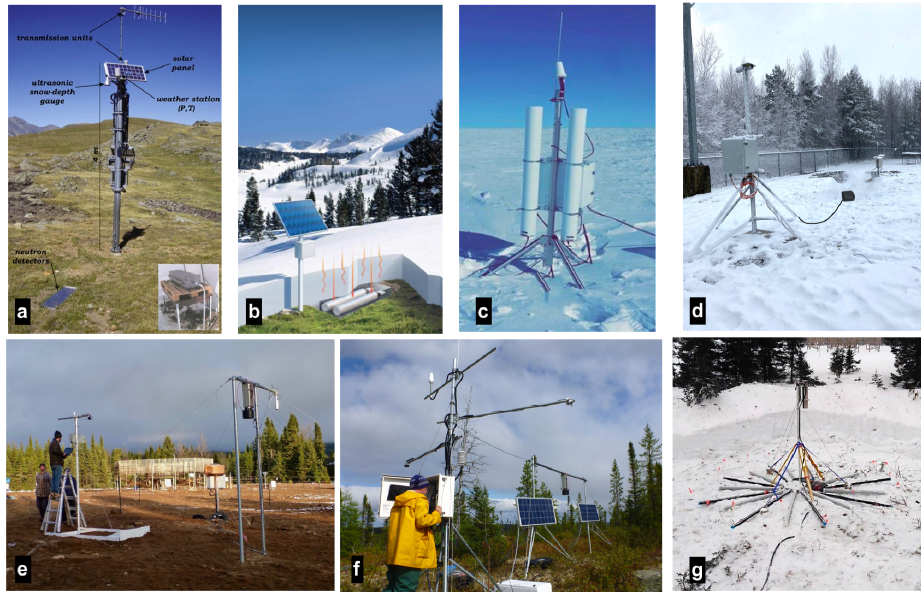
Figure 2. Photographs of sensors that were analyzed. (a) Cosmic-ray neutron probe (CRNP) from the EDF French network (nivomètre à rayonnement cosmique, NRC) at the Lac Noir station in Ecrins-Pelvoux massif, France. One can see the neutron probe buried in the ground (also shown in inset) and the mast, which carries ancillary meteorological sensors. Credit: Delunel et al. (2014). (b) SnowFox CRNP set at ground level beneath the snow cover. Similar to (a) , the system requires measurements of atmospheric conditions. Credit: Hydroinnova SnowFox manual. (c) Same sensor as in (b) , but the Hydroinnova CRS-1000/B sensor is placed above the snow, measuring ambient and upward neutron counts, with the latter being attenuated by the snowpack. Credit: Philip Marsh, Wilfrid Laurier University, Waterloo, ON, Canada; sensor in the tundra at Trail Valley Creek, Changing Cold Regions Network (http://ccrnetwork.ca, last access: 25 October 2021; Jitnikovitch et al., 2021). (d) GNSSr installed at the Université de Sherbrooke SIRENE (Site interdisciplinaire de recherche en environnement extérieur) site. The antenna that was placed on the ground (beneath the snow) was made visible at 3m from the mast, on top of which a second antenna was affixed. Credit: Alain Royer. (e) The FMCW radar (on the left) and the GMON scintillator (on the right) at the NEIGE- FM (NEIGE-Forêt Montmorency) site. A metallic plate on the ground in the field of view of the radar substantially increases radar echoes. In the background of panel (e) , one can see the solid precipitation gauge, which is known as the Double Fence Intercomparison Reference (DFIR). Credit: Alain Royer. (f) Meteorological and snow (GMON) automatic station at the Le Moyne–James Bay, Quebec, Canada, site in a sub-Arctic environment (Prince et al., 2019). Credit: Alain Royer. (g) The GMON scintillator at the NEIGE-Forêt Montmorency site set up to boost 40 K counts with pipes filled with potassium fertilizer. Credit: Sylvain